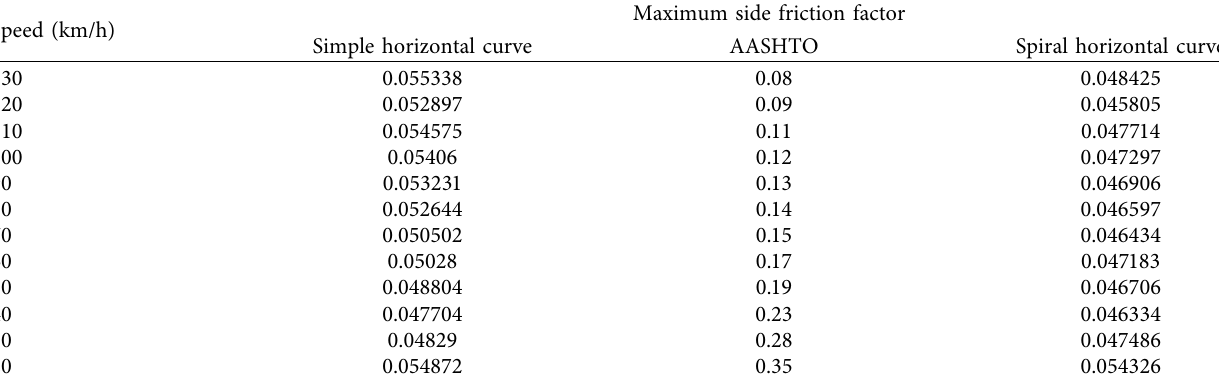
Table 17: Comparison of the maximum side friction factor for SUV between simple and spiral horizontal curves and AASHTO rec- ommended values at a radius of 1.3 R.